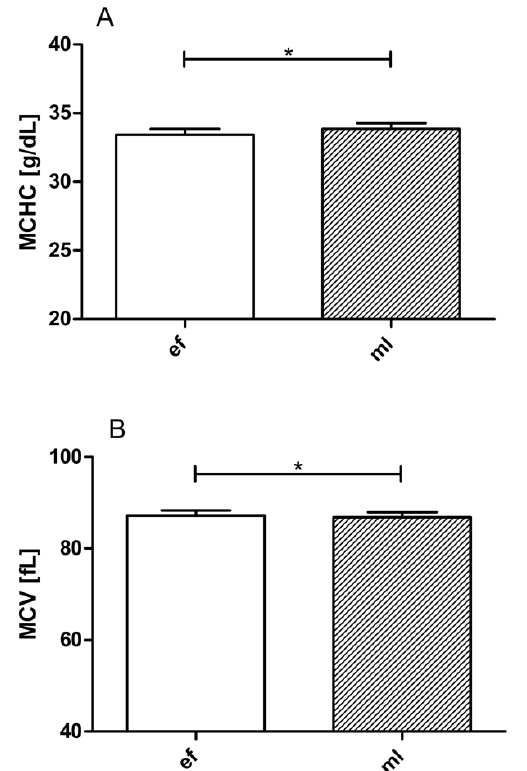
Figure 2. Baseline levels of mean corpuscular hemoglobin concentration (MCHC) values (panel A) and mean corpuscular volume (MCV) (panel B) during EF and ML phases. Data are expressed as means ± SEM. *… p ≤ 0.05.